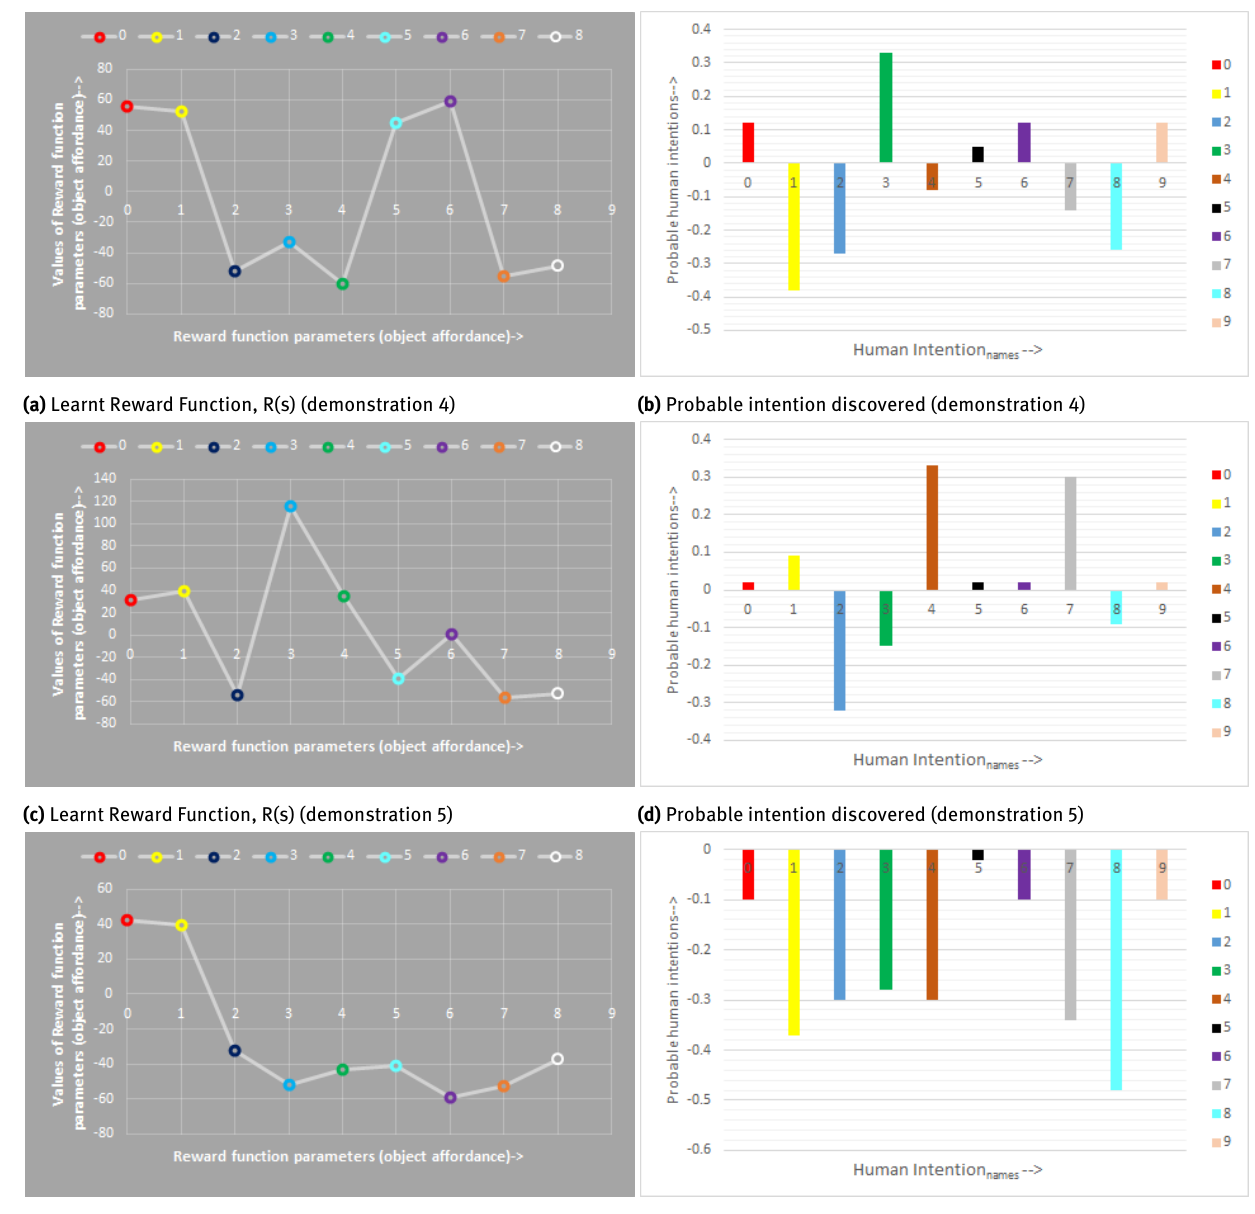
Figure 5: This figure is similar to Figure 4. It consists of three pair of graphs originated from three categories of demonstrations of